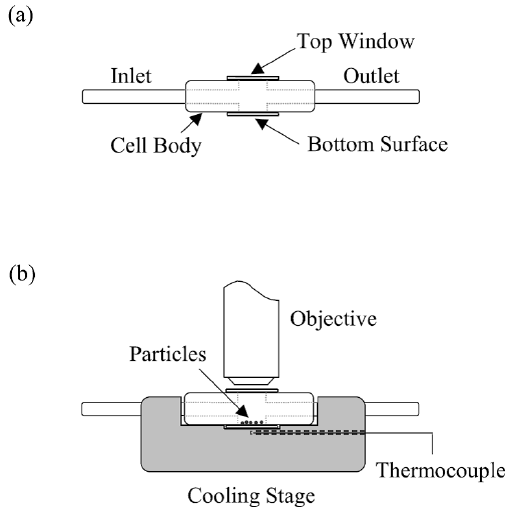
Figure 7. Schematic diagram of the flow cell-optical microscope apparatus developed by Bertram and co-workers to investigate particle-phase transitions: (a) side view of the flow cell; (b) side view of the entire apparatus. Particles were deposited on a glass slide placed on the bottom of the flow cell, which was mounted on a cooling stage. Objective: objective lens of the microscope. Reprint with permission by Parsons et al. (2004b). Copyright 2004 John Wi- ley & Sons,